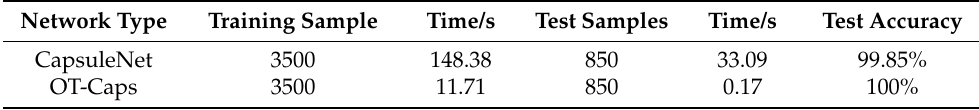
Table 6. Comparison results with the CapsuleNet